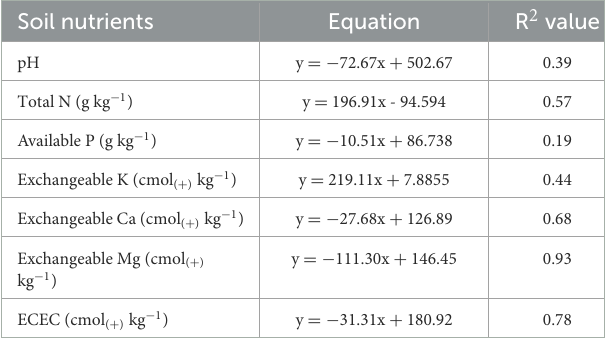
TABLE 6 Regression analysis of studied soil nutrients with CMI under various cropping systems.